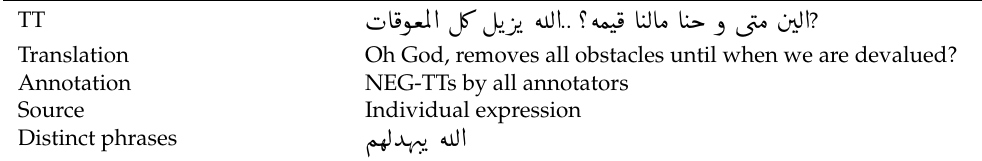
Table 10. Negative intention supplication.